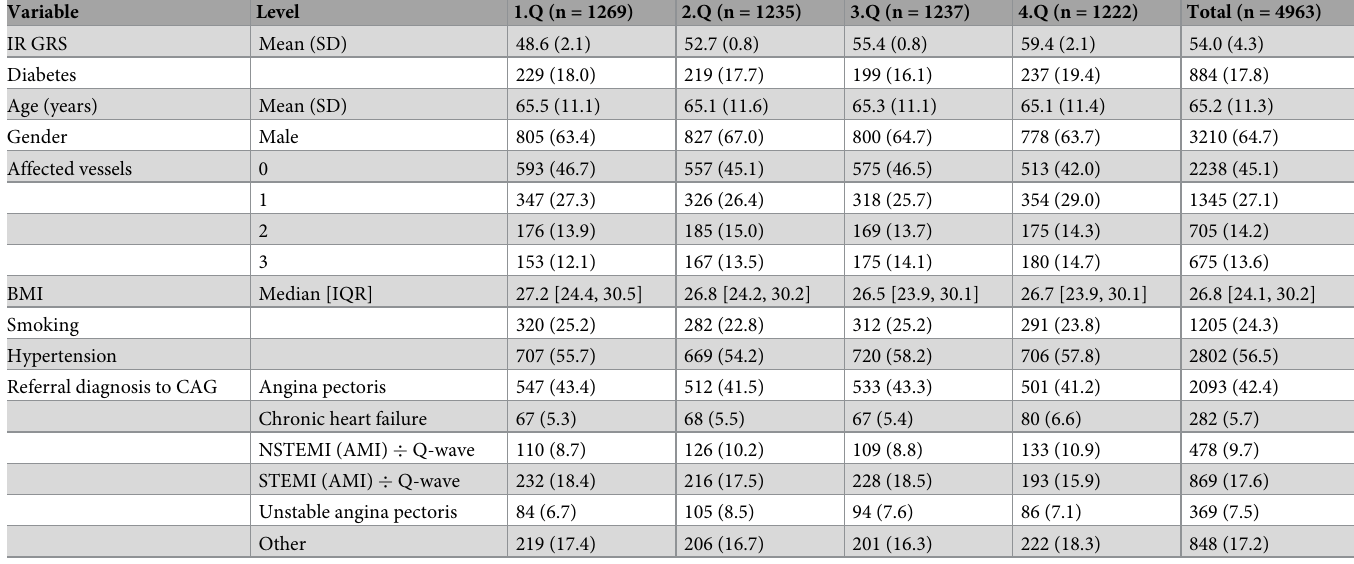
Table 1. Characteristics of the study population distributed on the quartiles (1.Q-4.Q) of the unweighted insulin resistance genetic risk score (IR